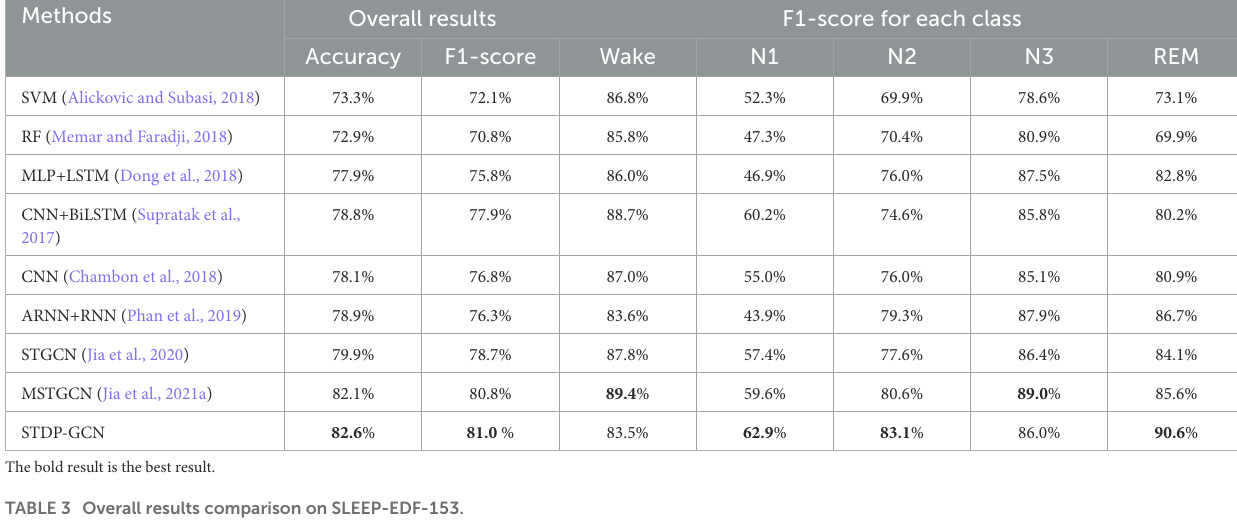
TABLE 3 Overall results comparison on SLEEP-EDF-153. Methods